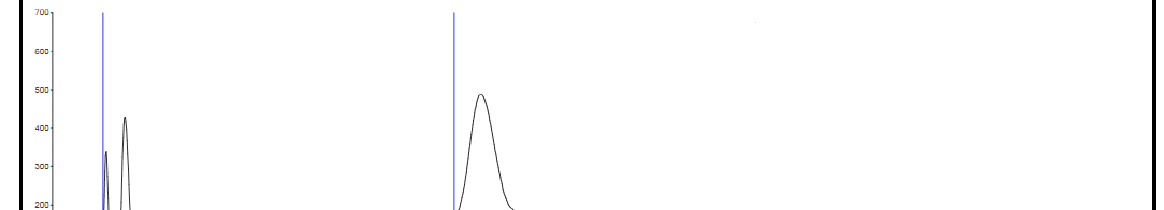
Figure 5. HPTLC diagram for Rutin standard